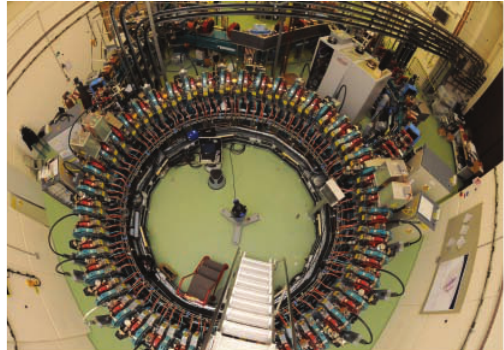
Figure 20: The EMMA proof-of-principle accelerator at the Dares- bury Laboratory.